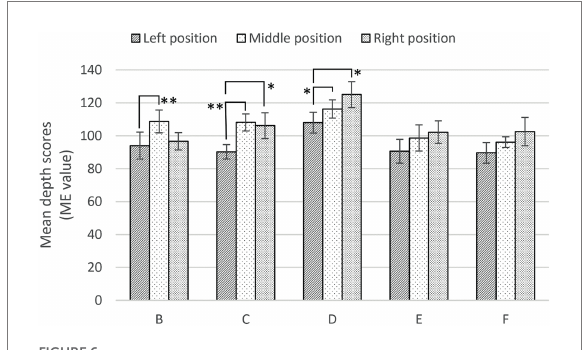
FIGURE 6 Mean depth scores (± standard error) with different visual cues in Task 1. *Significance, ( p < 0.05). **Significance ( p <